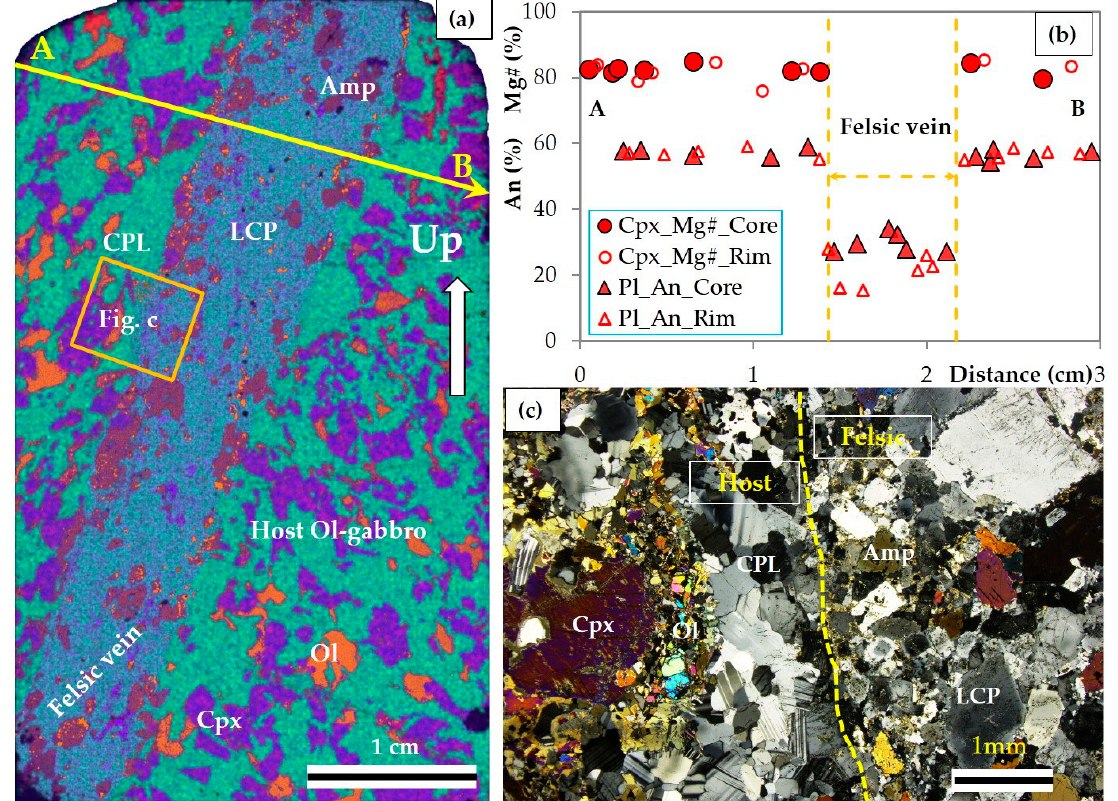
Figure 4. Felsic rock and host olivine gabbro interaction. ( a ) Phases X-ray mapping image of sample 64R2, 128–133 cm. Notice the sharp planar shape of the vein. ( b ) Chemical profile across the felsic vein. ( c ) Photomicrograph of the felsic boundary. Pl: Plagioclase. CPL: Calcic plagioclase. LCP: Less calcic plagioclase. Cpx: Clinopyroxene. Ol: Olivine.